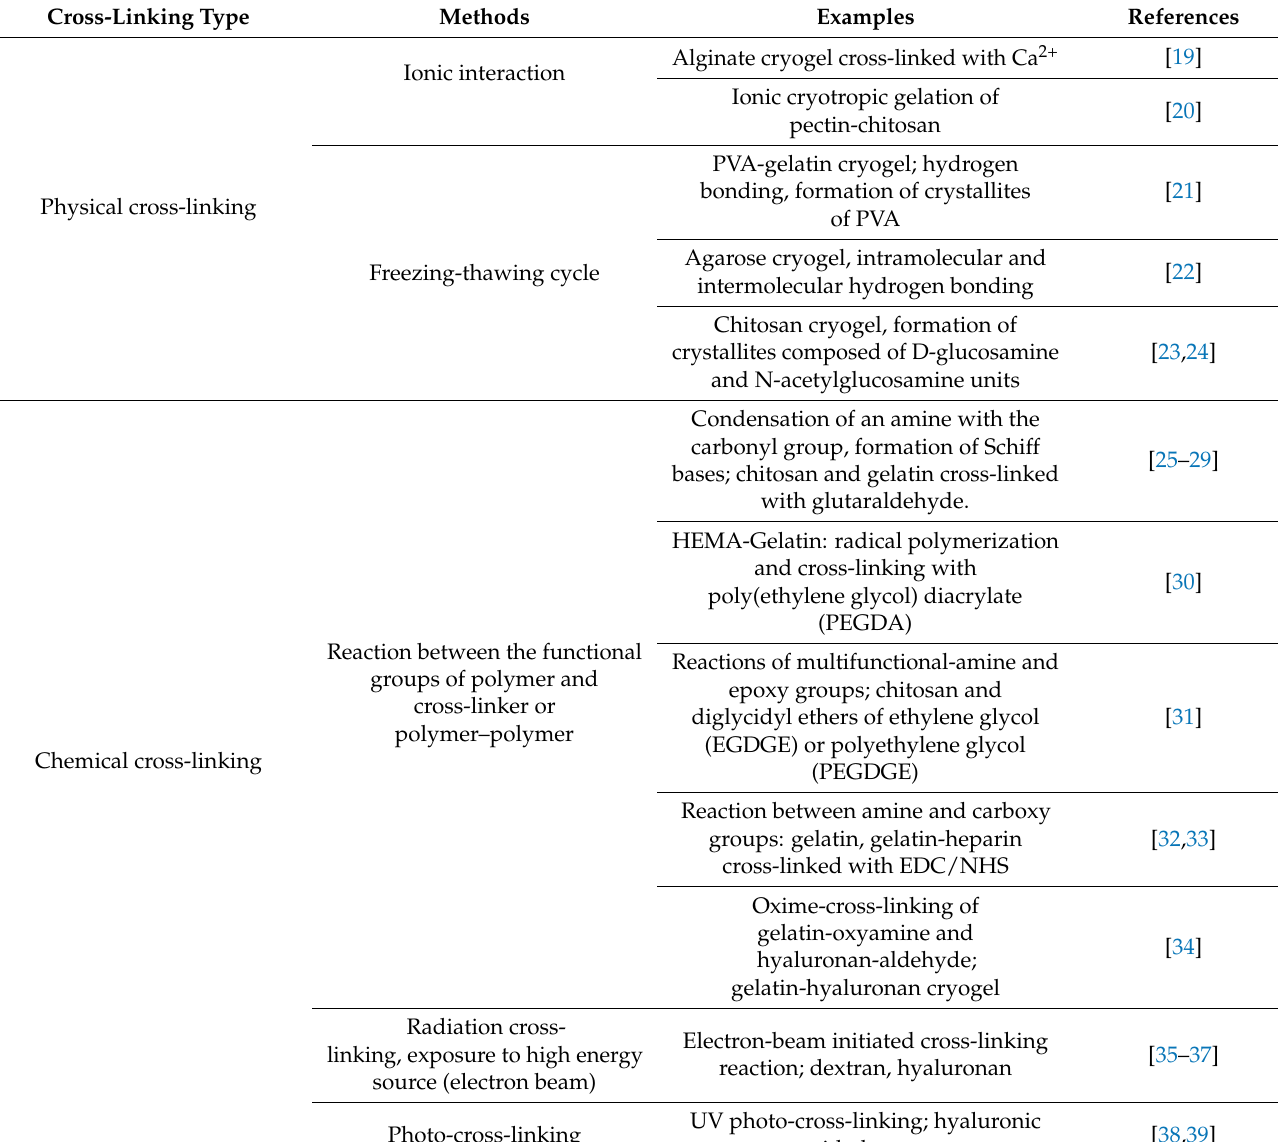
Table 1. Types of the cross-linking reactions for the formation of